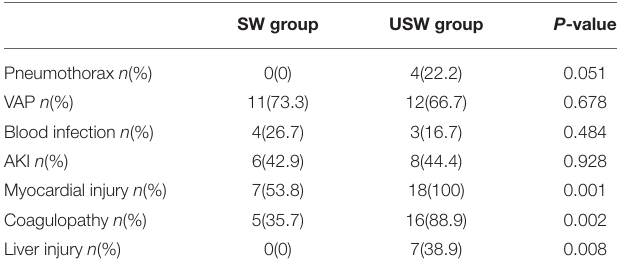
TABLE 2 | Complication comparison for successful weaning (SW) vs. unsuccessful weaning (USW). SW group USW group P -value Pneumothorax n